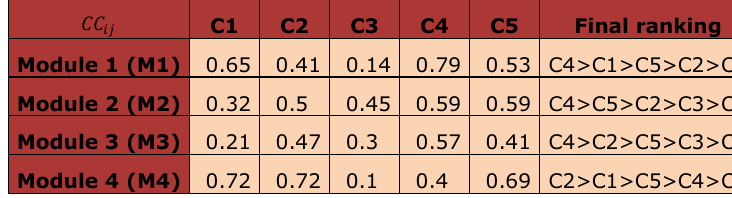
Table 6. Candidate’s ranking